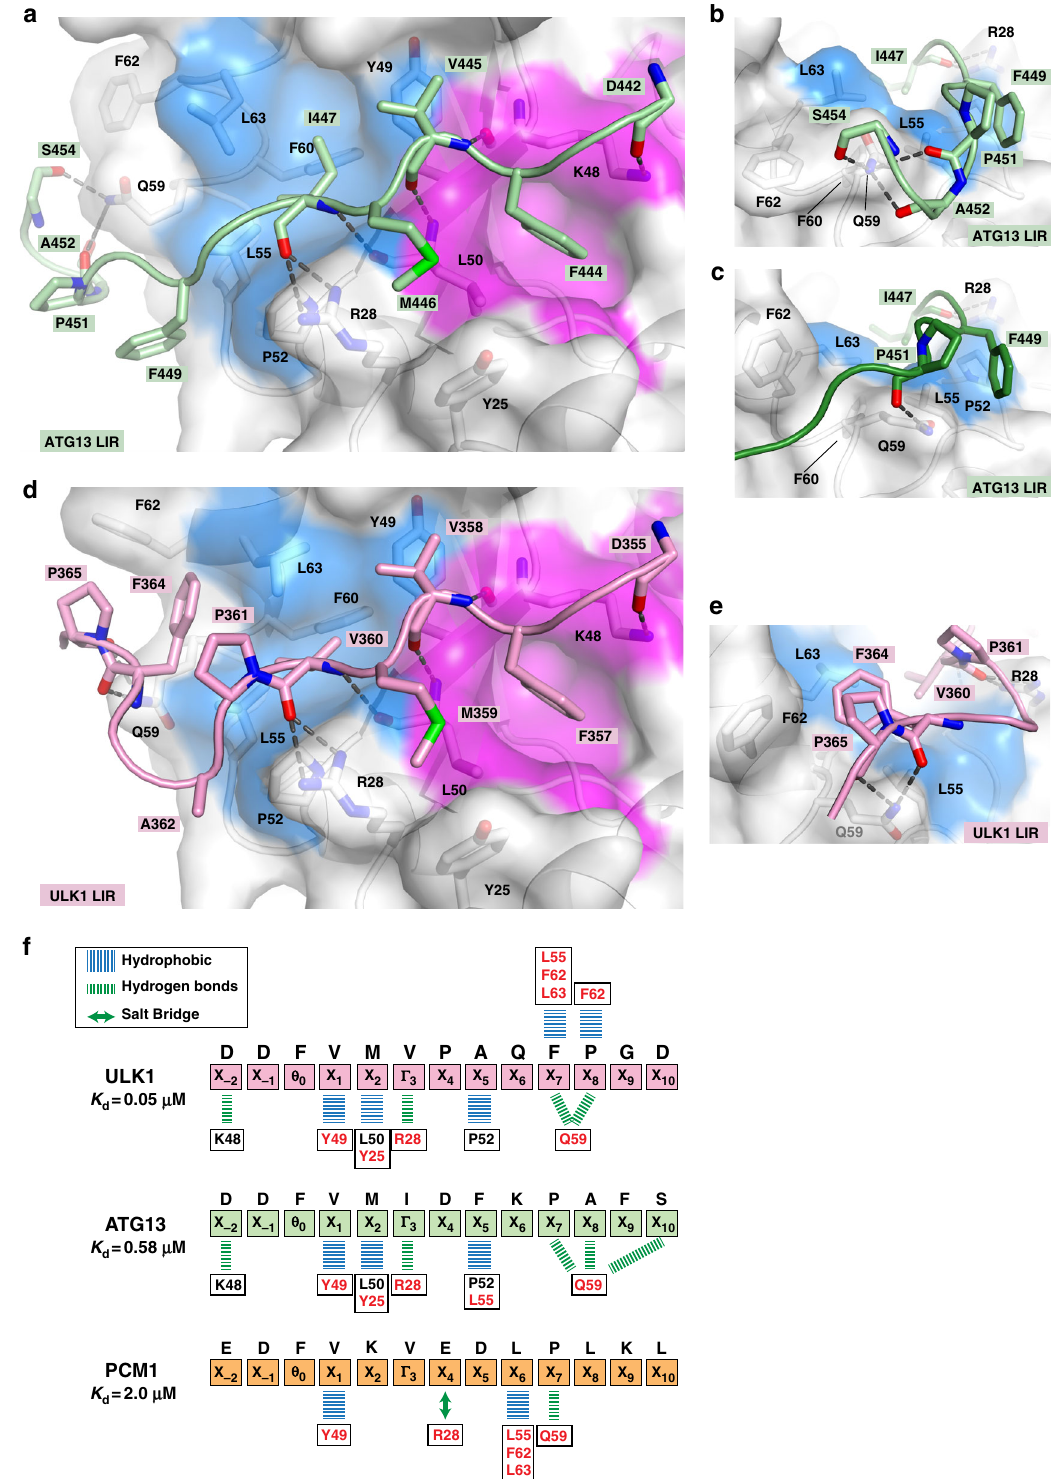
Fig. 2 ATG13 and ULK1 bind GABARAP via C terminally extended LC3-interacting region (LIR) motifs. a Structure of the ATG13 441 – 454 LIR bound to GABARAP in alternate conformation A. The ATG13 LIR sequence is shown in light green cartoon with interacting residues depicted as sticks. GABARAP is displayed in white cartoon and transparent surface with hydrophobic pocket 1 (pink) and 2 (blue). b , c Close-up view of Q59 GAB forming hydrogen bonds with main chain carbonyls of ATG13 LIR residues in alternate conformation A (light green) and B (dark green), respectively. d Structure of ULK1 354 – 366 LIR-GABARAP complex. The ULK1 LIR sequence is shown in pink cartoon with interacting residues depicted as sticks. e Close-up view of interactions between GABARAP residues, Q59 GAB , F62 GAB , and L63 GAB , with ULK1 LIR residues in position X 7,8 (F364 ULK1 , P365 ULK1 ). f Schematic overview of non-canonical LIR interactions observed in the structures of GABARAP bound to ULK1 (pink), ATG13 (green), and PCM1 (orange) LIR motifs. Blue lines indicate hydrophobic interactions, green lines hydrogen bonds, and green double arrow salt bridges. Strictly conserved residues are boxed and displayed in black; non-conserved residues are boxed and displayed in